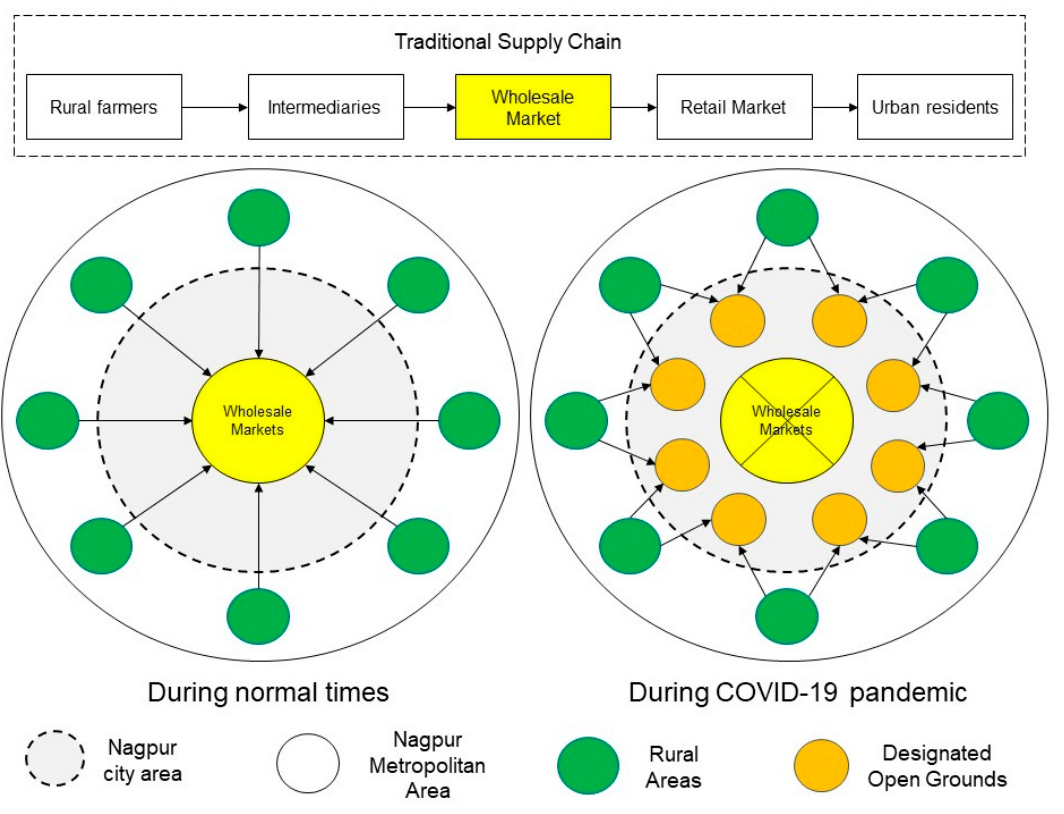
Figure 3. Implications of COVID-19 on traditional food supply chain in Nagpur (Image source: the authors).